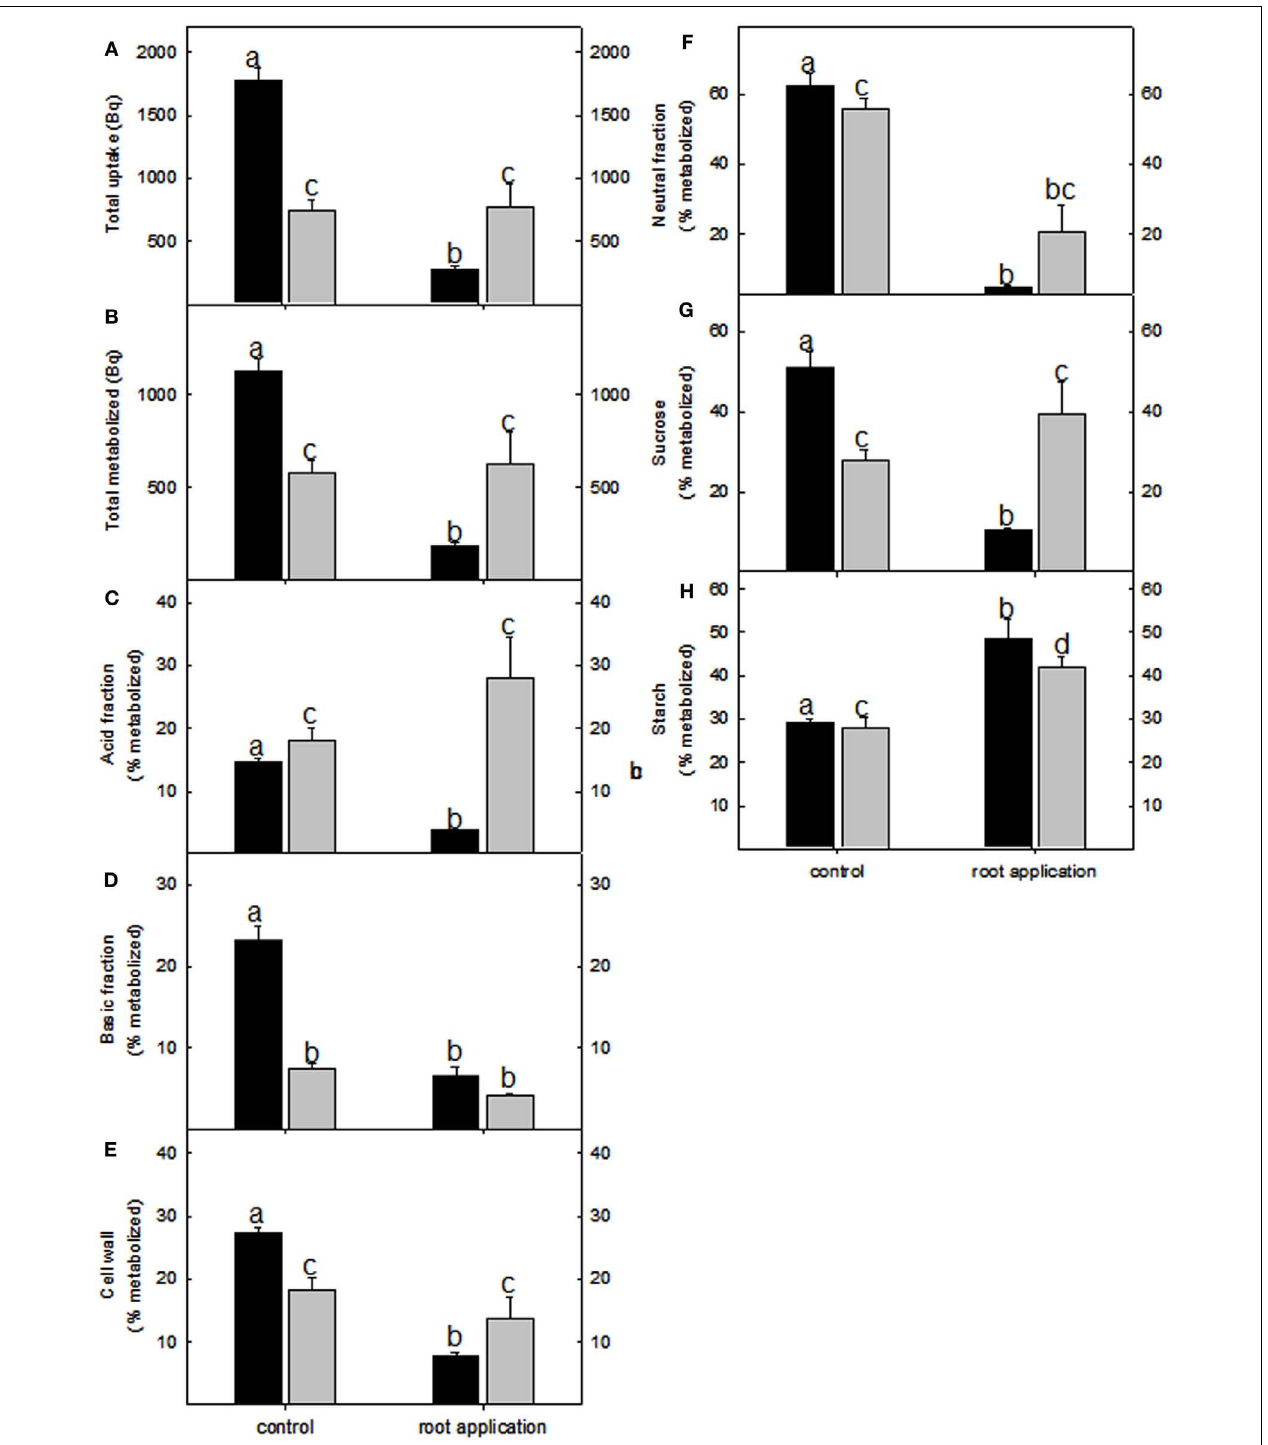
incubation period. Label distribution toward the (G) sucrose and (H) starch pools.The values are expressed as a percentage of the total radiolabel metabolized and are the mean ± SE ( n = 6).The data was analyzed using one way ANOVA followed by Fisher’s least significant difference, bars that do not share letters are significantly different ( P < 0.05) from each